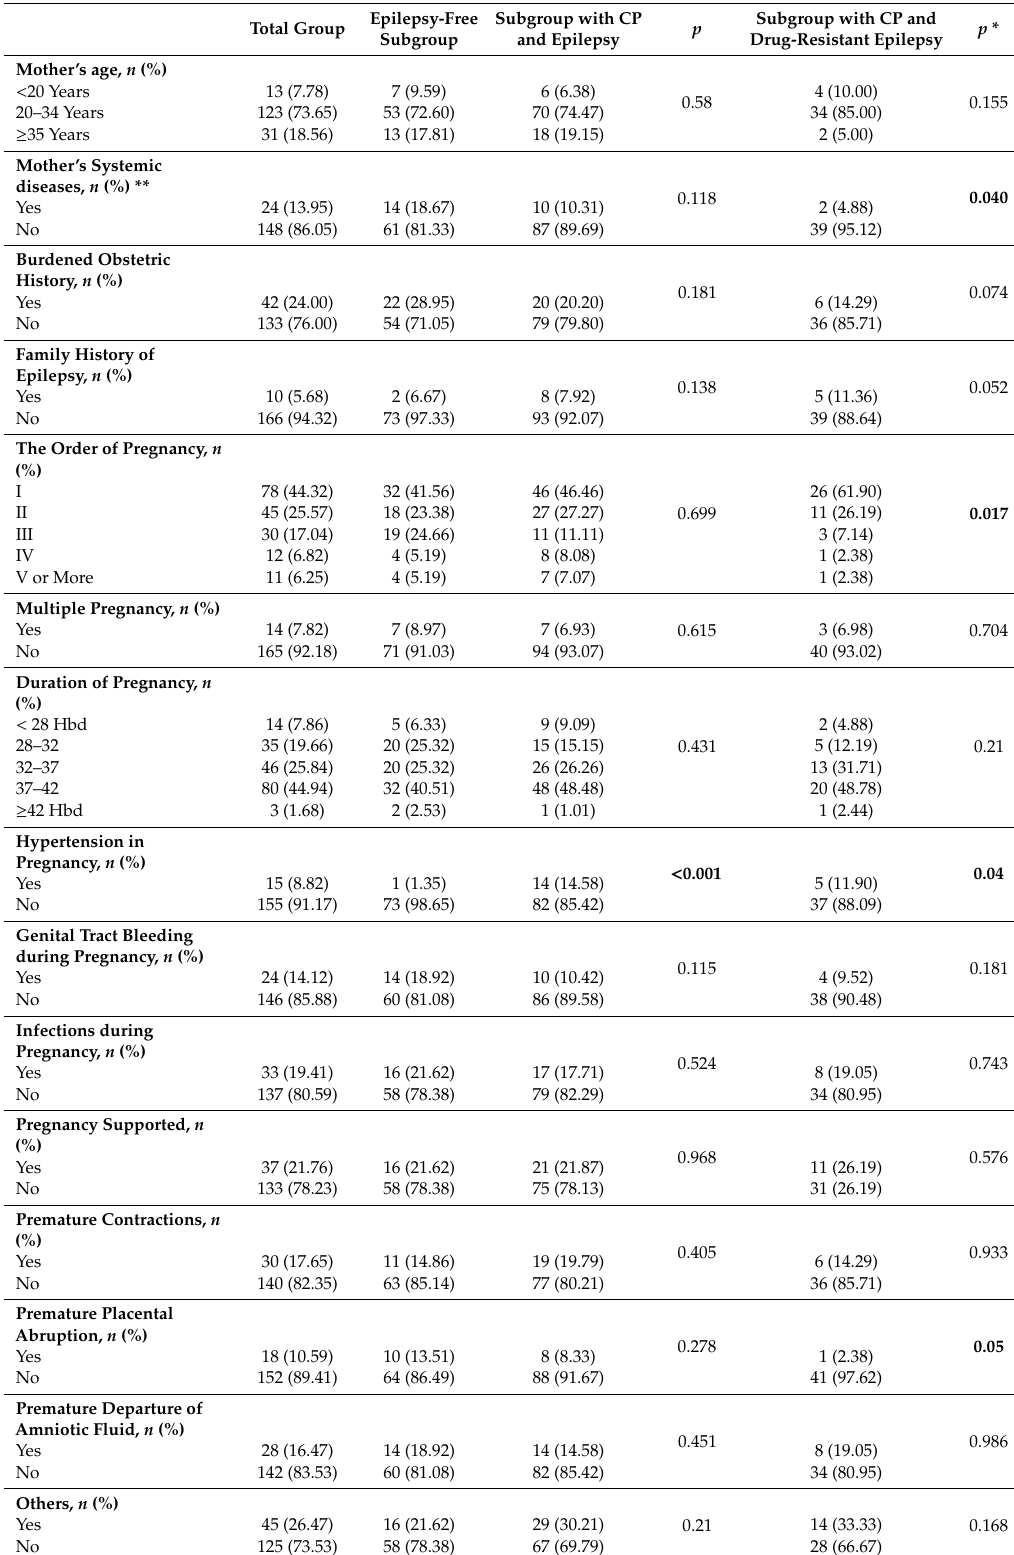
CP—cerebral palsy; * In comparison to CP patients without epilepsy; ** Mother’s systemic diseases: asthma, congenital heart defect, cardiac rhythm disturbances, thyroid diseases, cancer, rheumatologic diseases, mental health problems, intellectual disability. Data on pregnancy are missing in 11